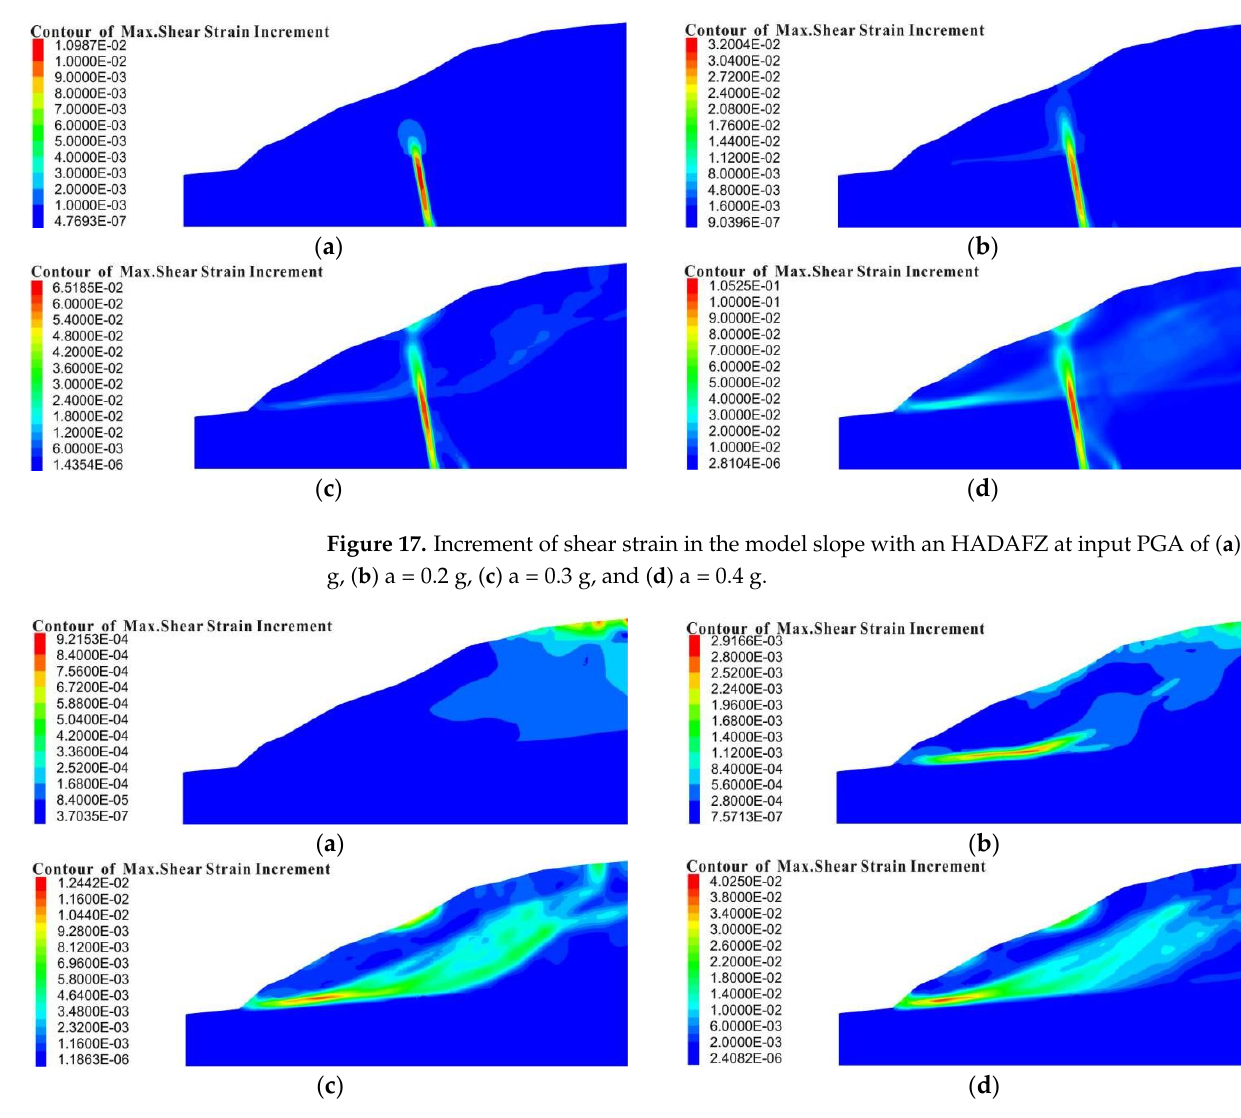
Figure 18. Increment of shear strain in the model slope without fault zone at input PGA of ( a ) a = 0.1 g, ( b ) a = 0.2 g, ( c ) a = 0.3 g, and ( d ) a = 0.4 g.